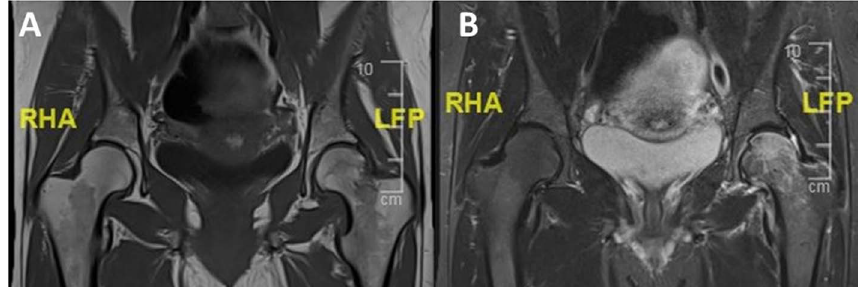
Figure 1. MRI performed at 27 weeks of gestation showed a decreased signal intensity in the proximal femur on T1-weighted imaging (A) and an increased signal on the T2-weighted imaging sequence. (B) MRI; Magnetic Resonance Imaging.